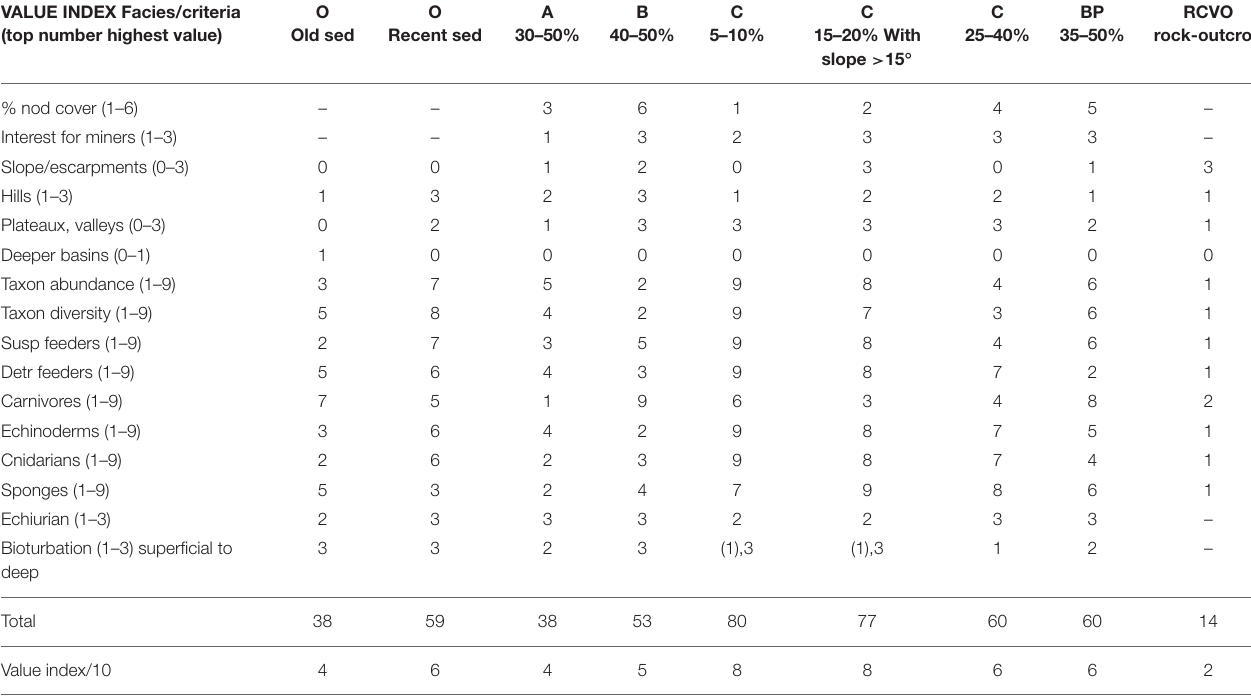
TABLE 3A | “Value Indexes” for NIXO 45 based on results of UNESCO/COI baseline survey (Tilot, 2006a). VALUE INDEX Facies/criteria (top number highest